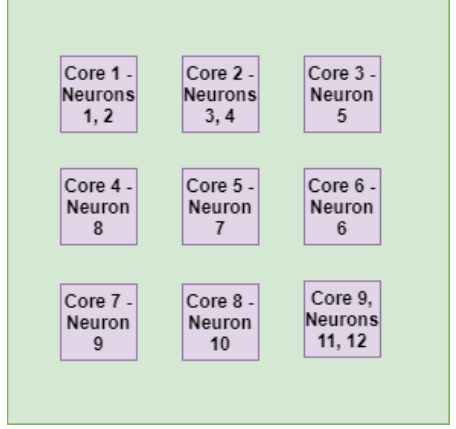
Figure 10. Direct mapping for nine-cores architecture.